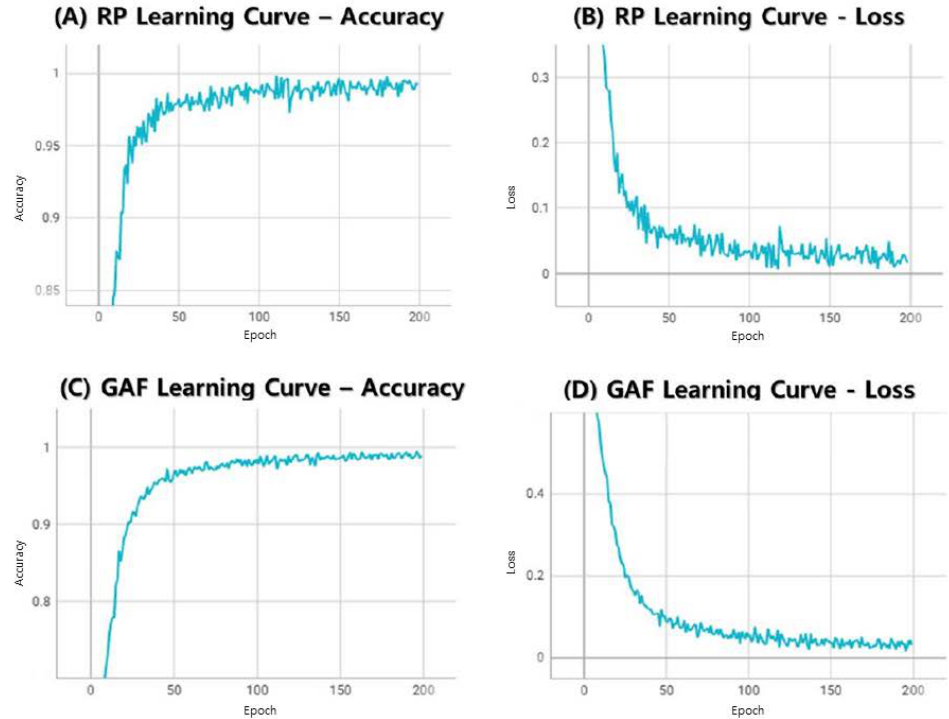
Figure 4. Learning curve of Recurrence Plot and Gramian Angular